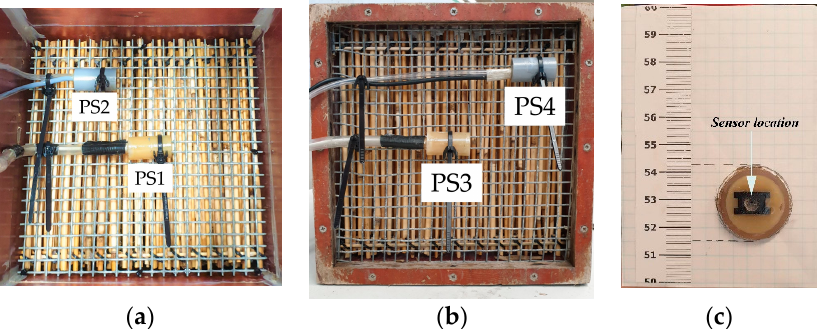
Figure 3. Pressure sensors installed at the top ( a ) and the bottom ( b ) of the main tube, and the configuration of the pressure head ( c ).